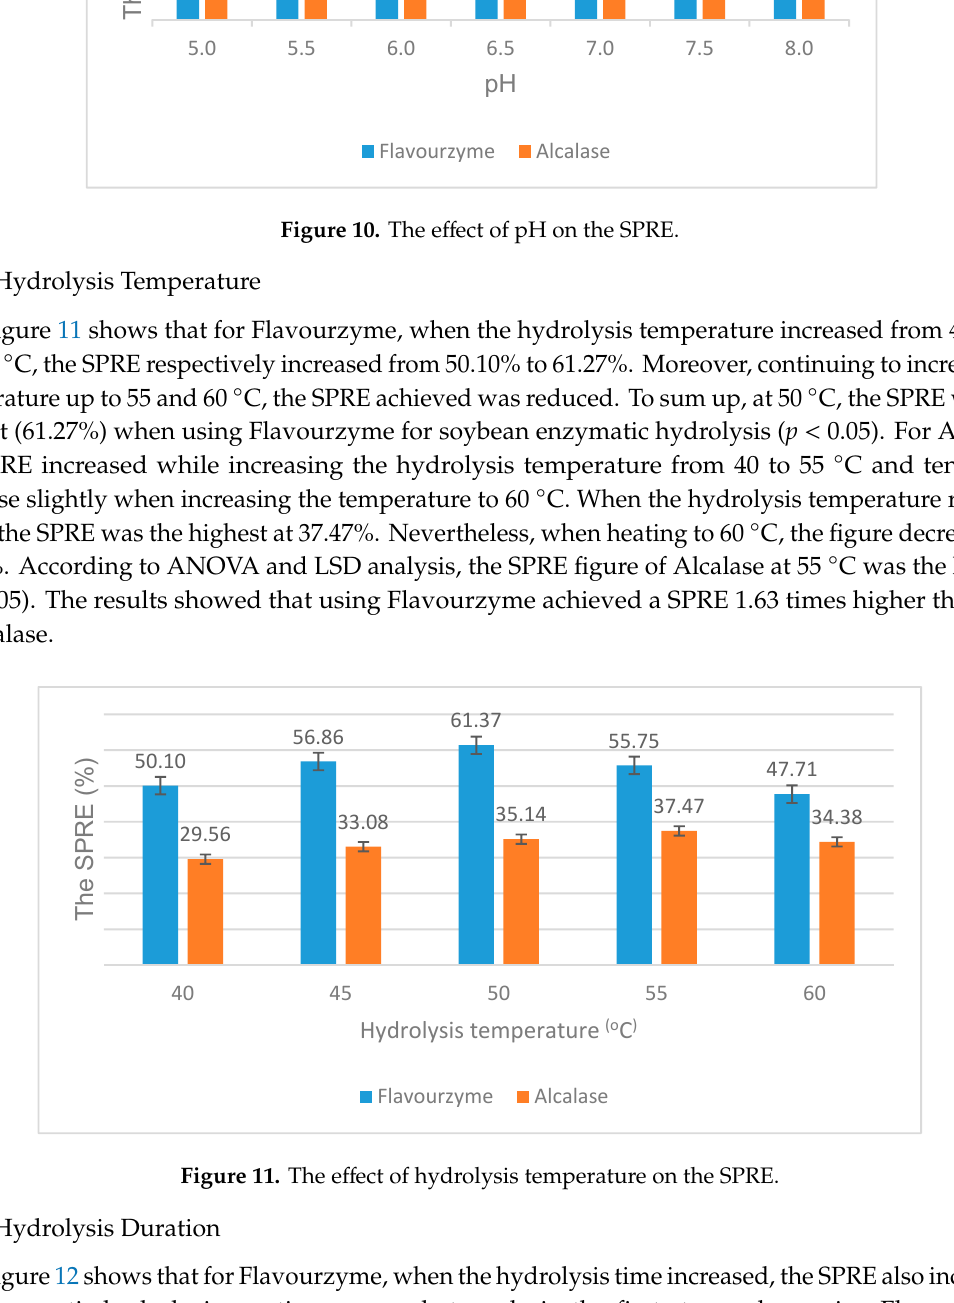
Figure 12. The effect of hydrolysis duration on the SPRE. Similarly, when using Alcalase and increasing the duration from 90 to 180 min, the SPRE increased from 26.53% to 39.21%. However, if the duration was up to 210 min, the SPRE increase was not significant. According to ANOVA, when using Flavourzyme, the SPRE at 150, 180, and 210 min had no statistically significant difference ( p < 0.05). For Alcalase, the SPRE at the duration of 180 min was not significantly different from 210 min. So, 150 min is a reasonable hydrolysis duration to hydrolyze with Flavourzyme; while 180 min is a reasonable hydrolysis duration with Alcalase to make the process highly effective and economical. Compared with some previous studies, there were differences due to the differences in substrate characteristics and hydrolysis conditions (enzyme activity, enzyme activity). According to Lee et al. (2001), the SPRE attained 59.5% when combining thermal pre- treatment and enzymatic hydrolysis 95 °C for 1 h [26].